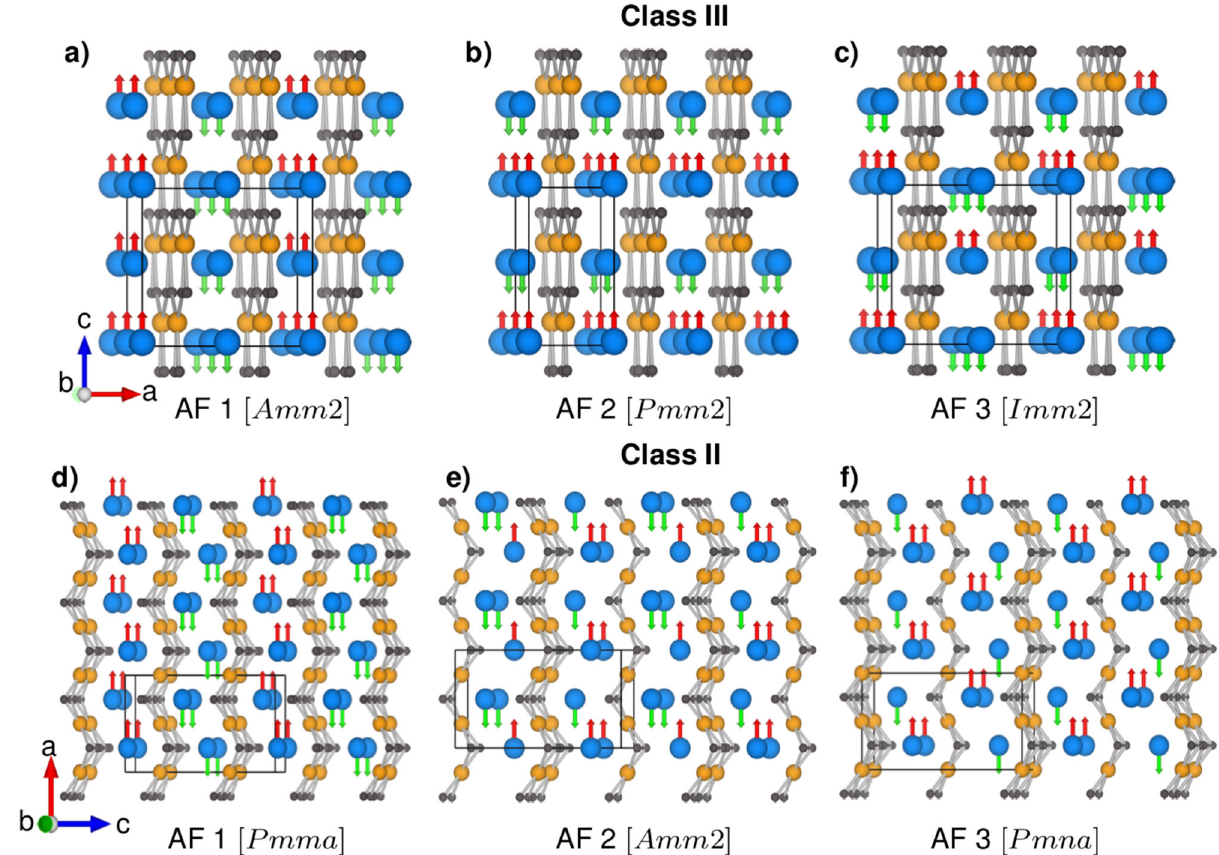
Fig. 6 Magnetic con fi gurations. AFM con fi gurations considered for compounds belonging to a – c the symmetry classes III and d – f the symmetry class II. The rare earth atoms, transition metal atoms and carbon atoms are, respectively, shown with blue, yellow and gray spheres. The relative spin directions on the R atoms are represented by arrows. The choice of quantization axis is only schematic. For each case, the resulting lower-symmetry space groups are also